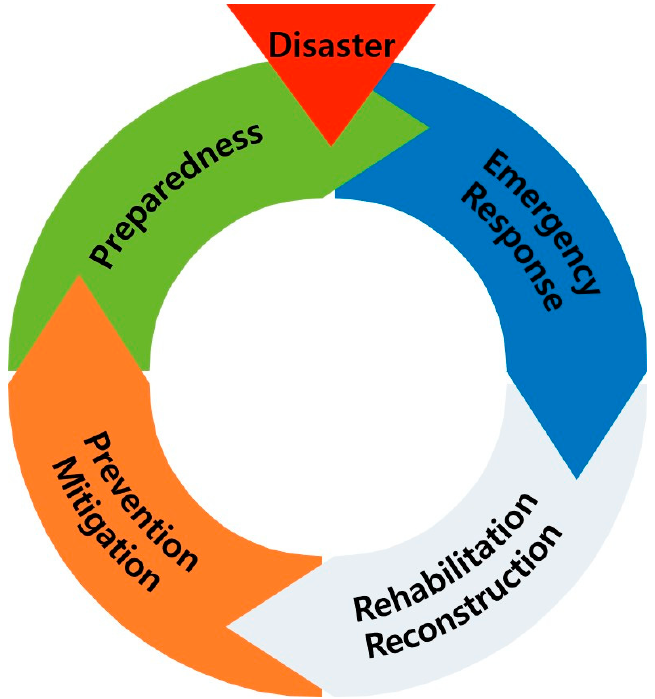
Figure 1. The four phases of disaster (disaster cycle). Source: Hyejeong Park, used with permis- sion.